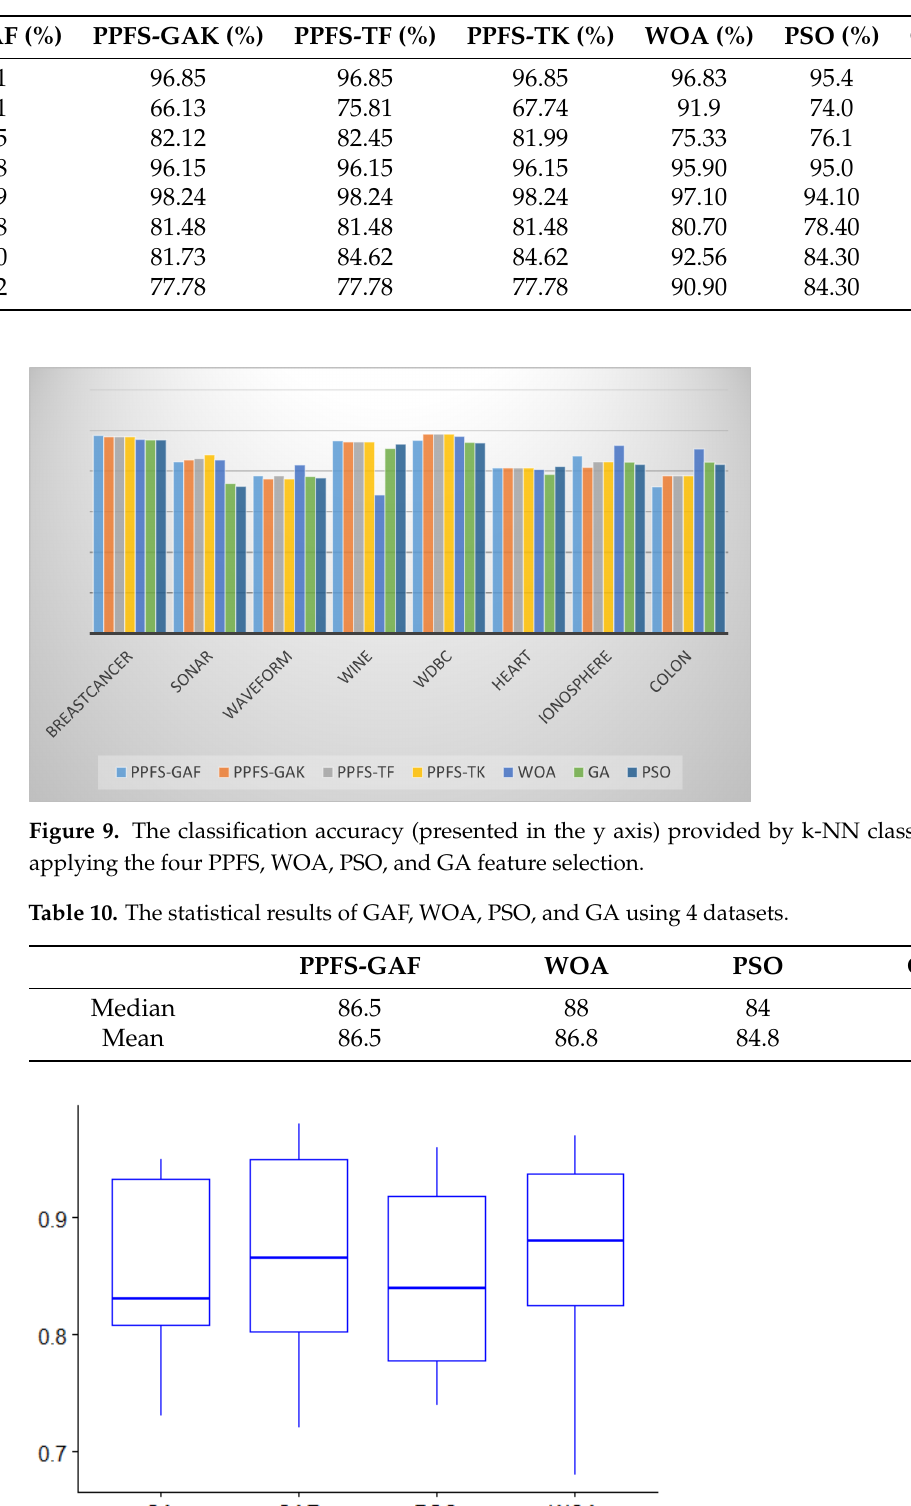
Table 9. The classification accuracy provided by the k-NN classifier after applying the four PPFS, WOA, PSO, and GA feature selection.